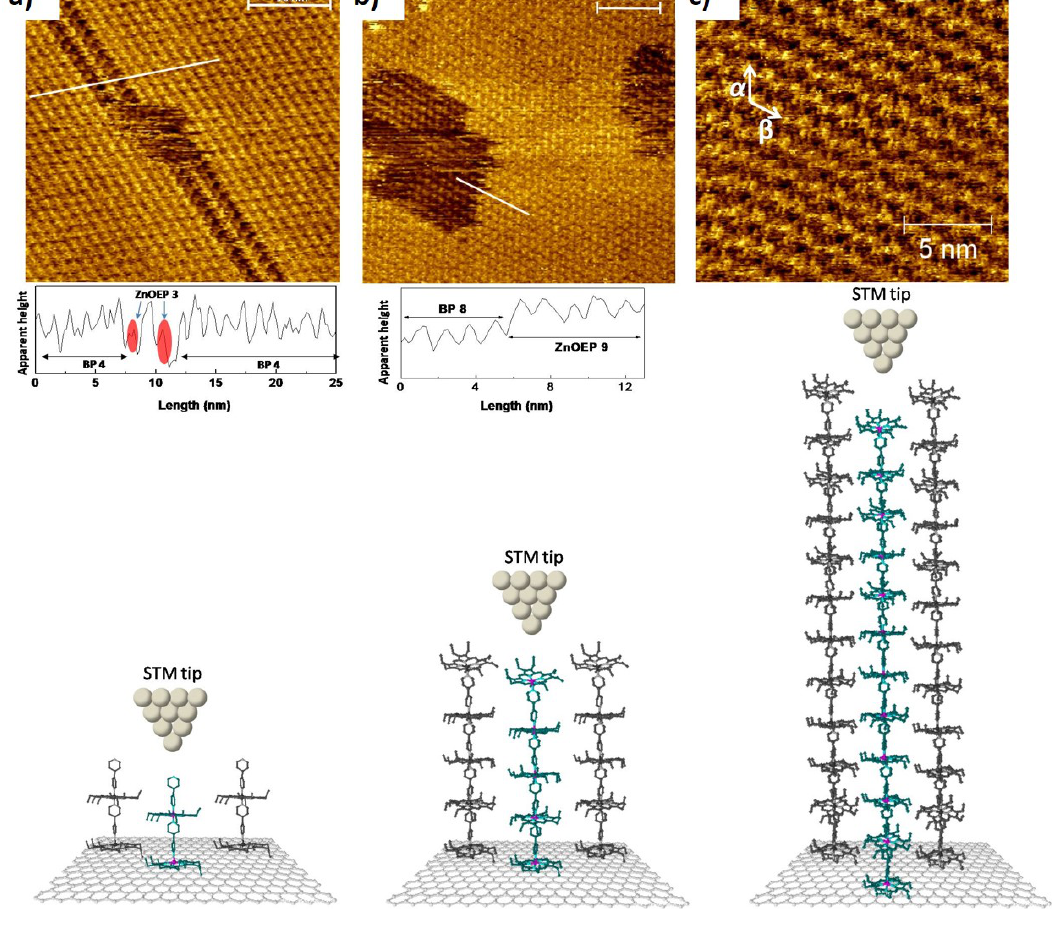
Figure 9. STM images of bipyridine monolayers assembled in intercalated structures with ZnOEP: ( a ) represents the fourth self-assembled monolayer (BP) developed over the third layer (darker regions—ZnOEP); ( b ) the ninth layer (ZnOEP) developed over the eighth layer (darker regions—BP), with corresponding line profiles evidencing the height differences in the monolayer; and ( c ) the twenty-third layer (ZnOEP). The schematics immediately bellow the STM images are models of the BP-ZnOEP alternating self-assembled layer-by-layer. (Reprinted with permission from reference [8]. Copyright 2014 American Chemical